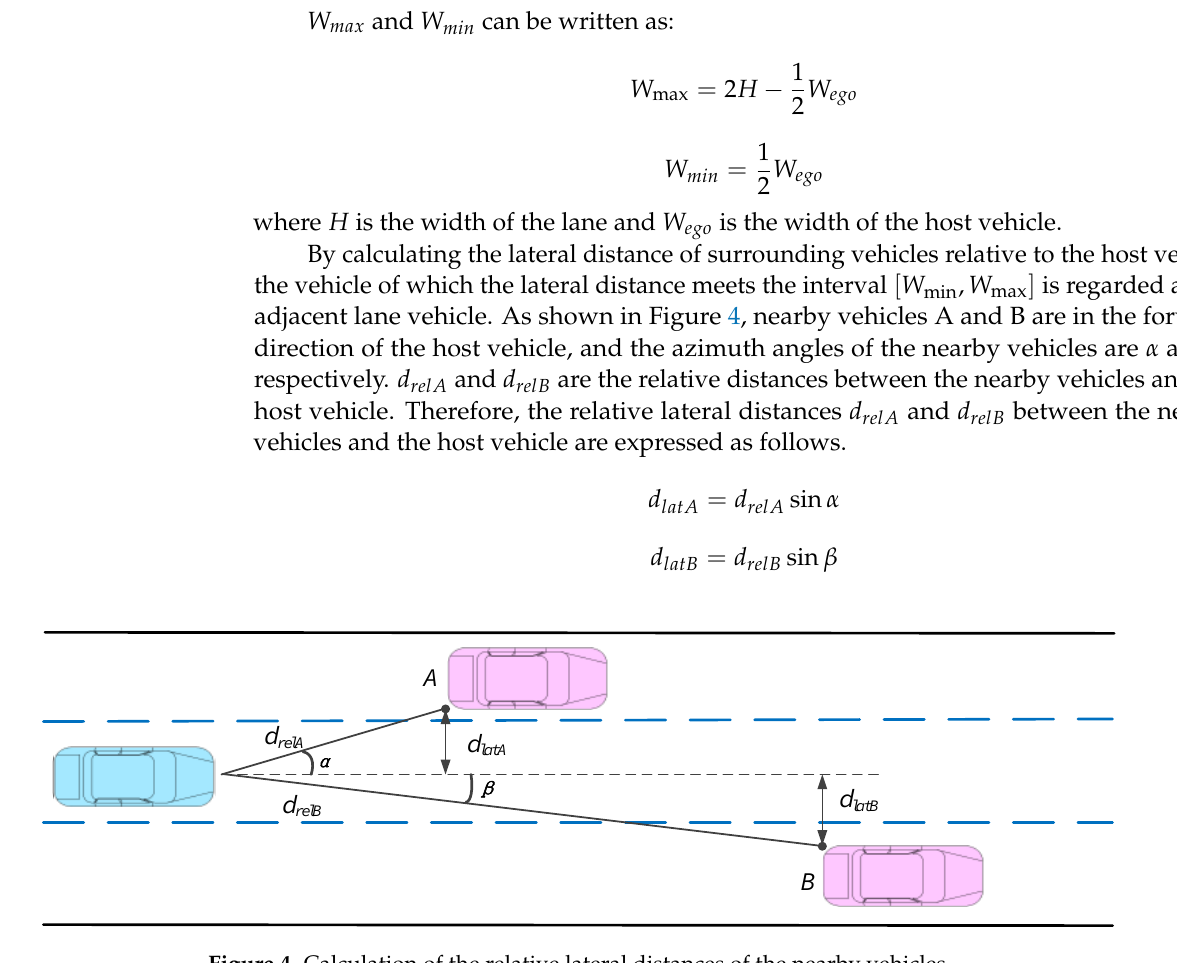
Figure 3. Determination of the lateral distance range.